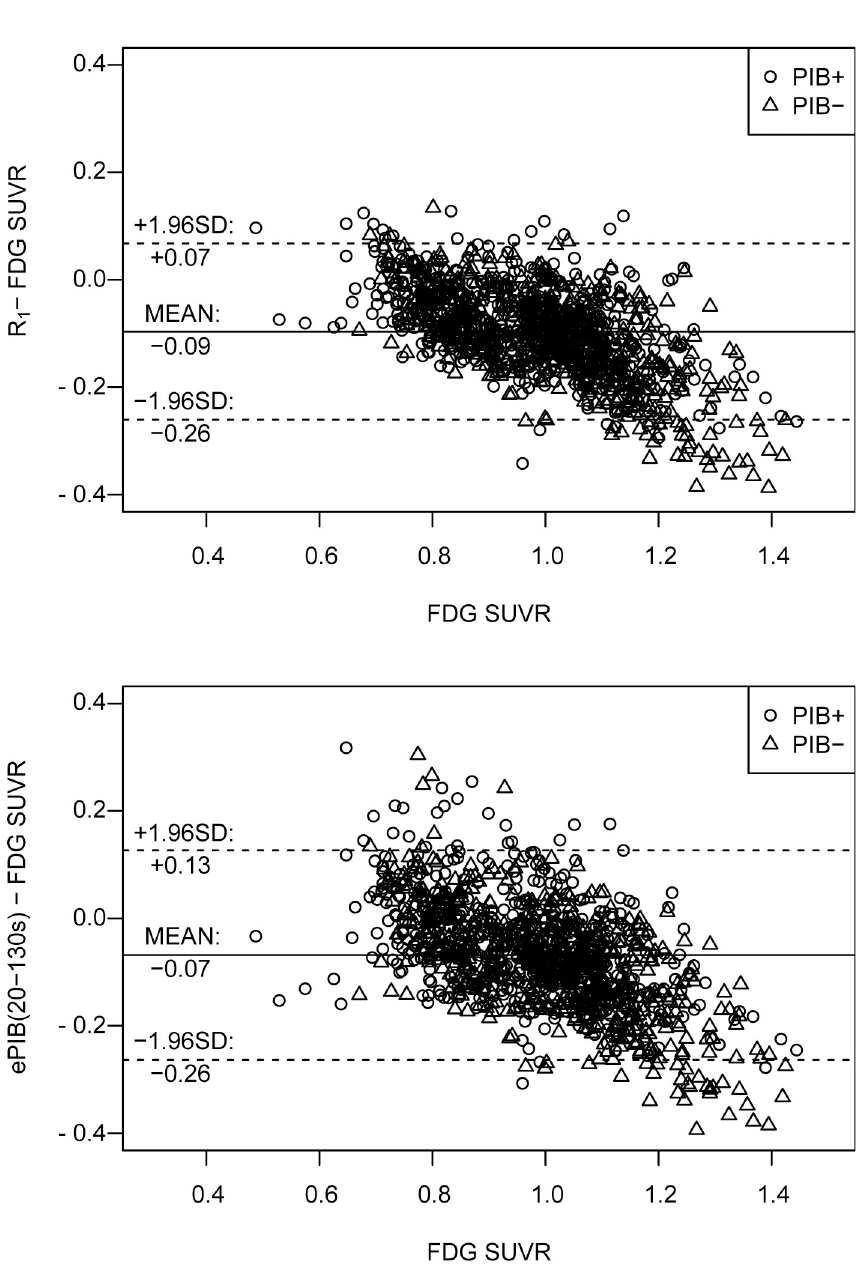
Fig 5. Bland-Altman plot. Bland-Altman plot showing the difference between the values of rCBF assessed by different methods (by R 1 , on the top row, and by ePIB(20 to 130 seconds), on the bottom, estimations and from the normalized FDG uptake). Circles represent data from the PIB+ group, while triangles represent PIB-. The full line is at the mean difference value for all data (not classified in groups), and the dashed lines delimit the 95% agreement interval (at mean ± 1.96 × standard deviation).